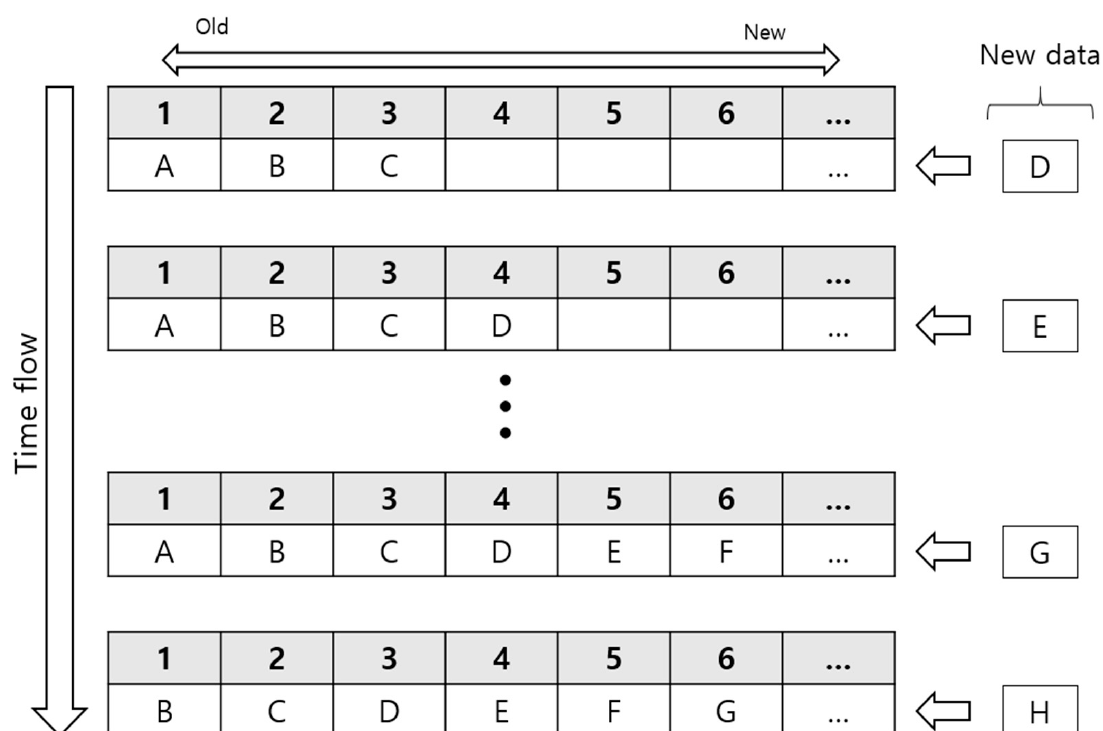
Figure 5. FIFO-based queue for tracking N-most recent data.